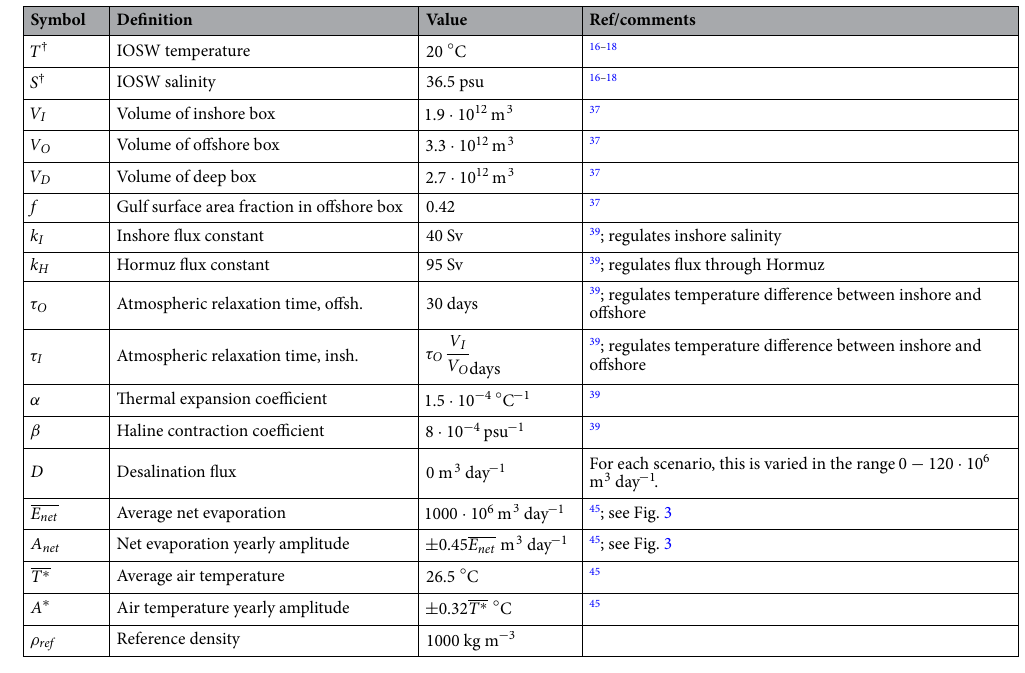
Table 2. Baseline model